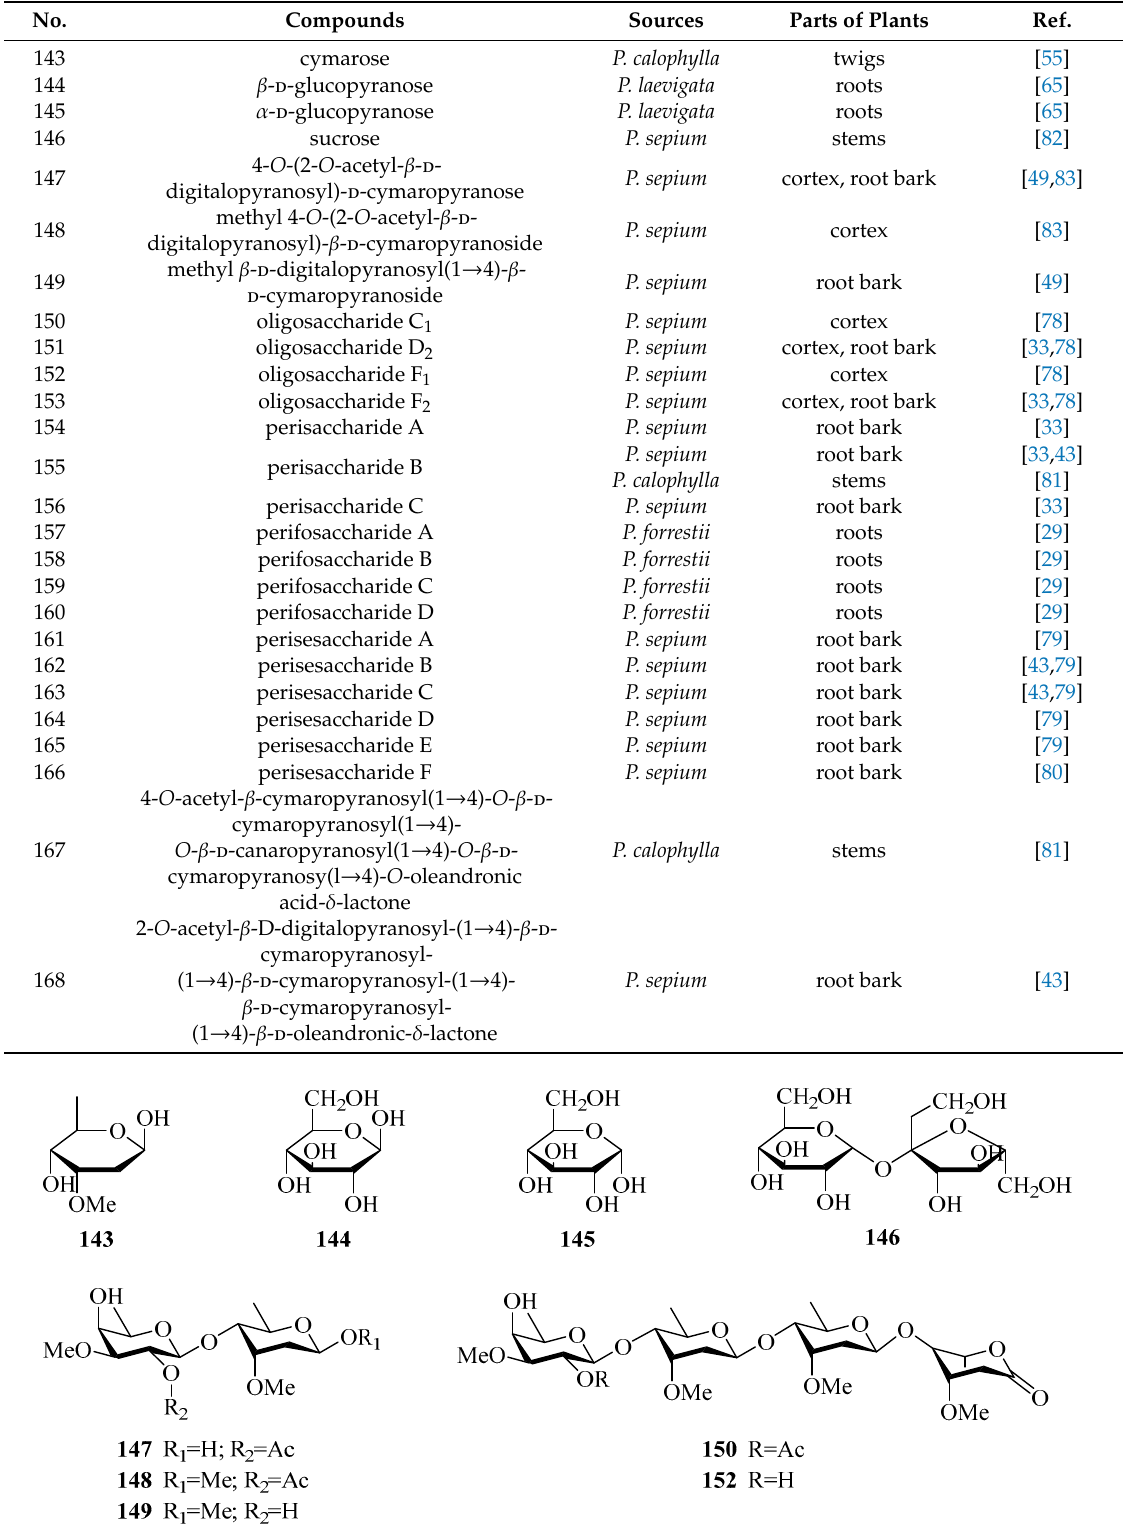
Table 3. Carbohydrates from the genus Periploca